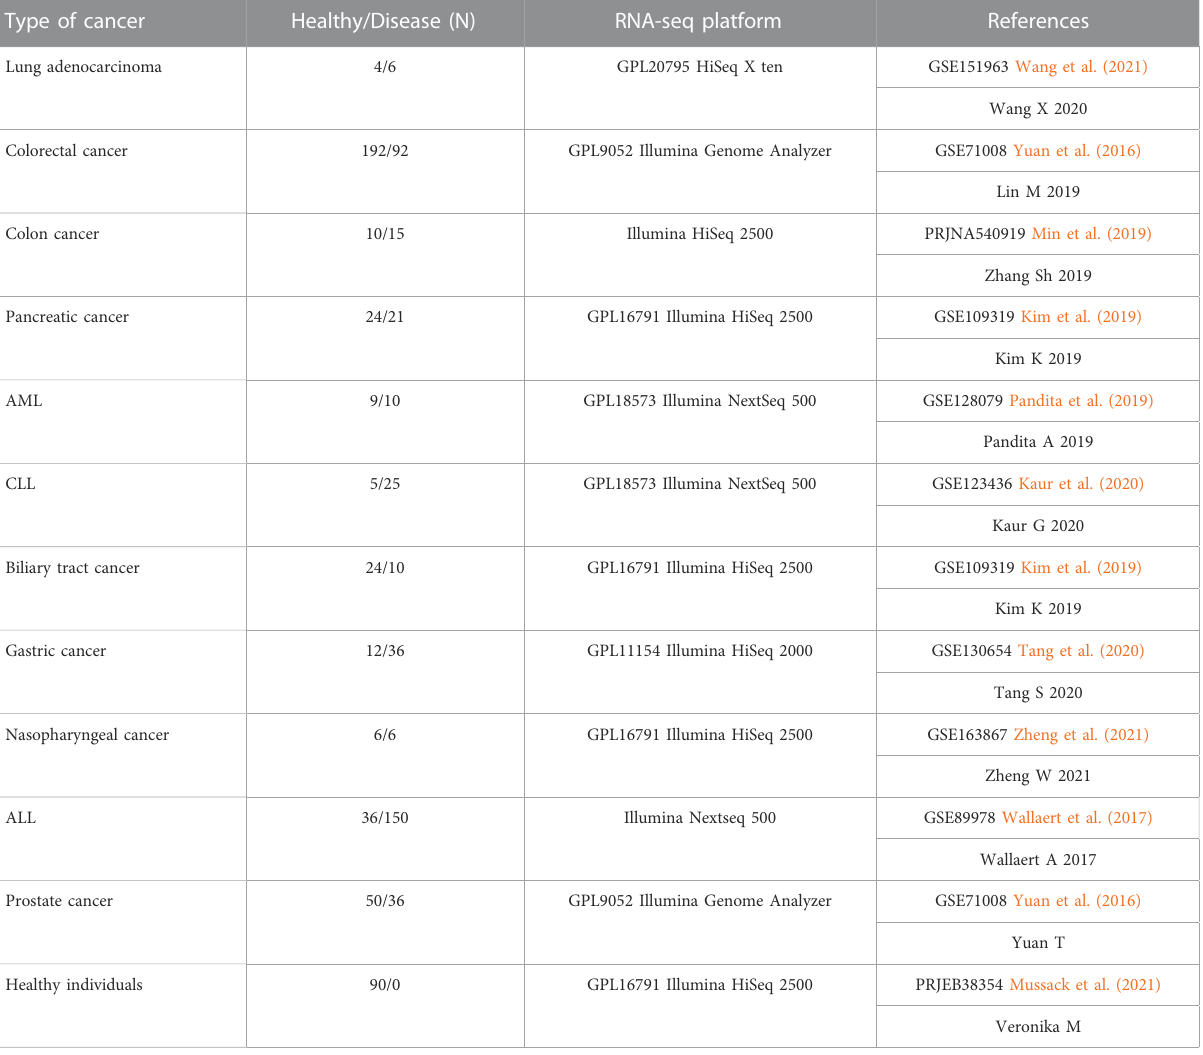
TABLE 1 Cancer small RNA-seq raw datasets. Eleven different cancer datasets with their speci fi c controls in nine different tissues. One time series dataset obtained from ten healthy individuals including 90 samples (Mussack et al., 2021). All the samples were obtained from blood in each cancer. All datasets are available in Gene Expression Omnibus (GEO) database (c). AML: acute myelogenous leukemia, CLL: chronic lymphocytic leukemia, ALL: acute lymphocytic